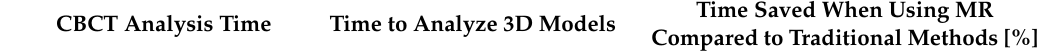
Table 7. The comparison of the MR application with the traditional methods in root canal